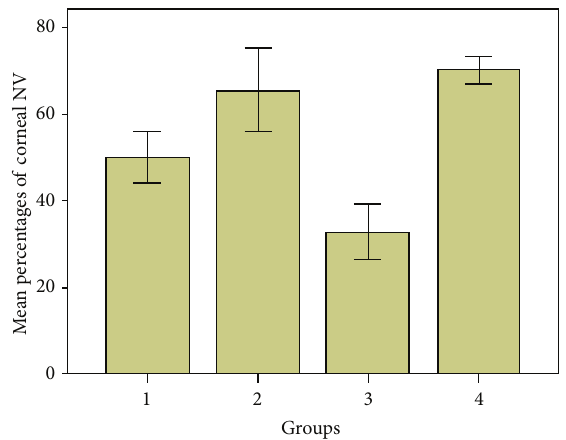
Figure 2: The percentage of corneal neovascularization by groups. Subconjunctivally tigecycline-treated eyes (group 3) showed signif- icantly less corneal neovascularization than other